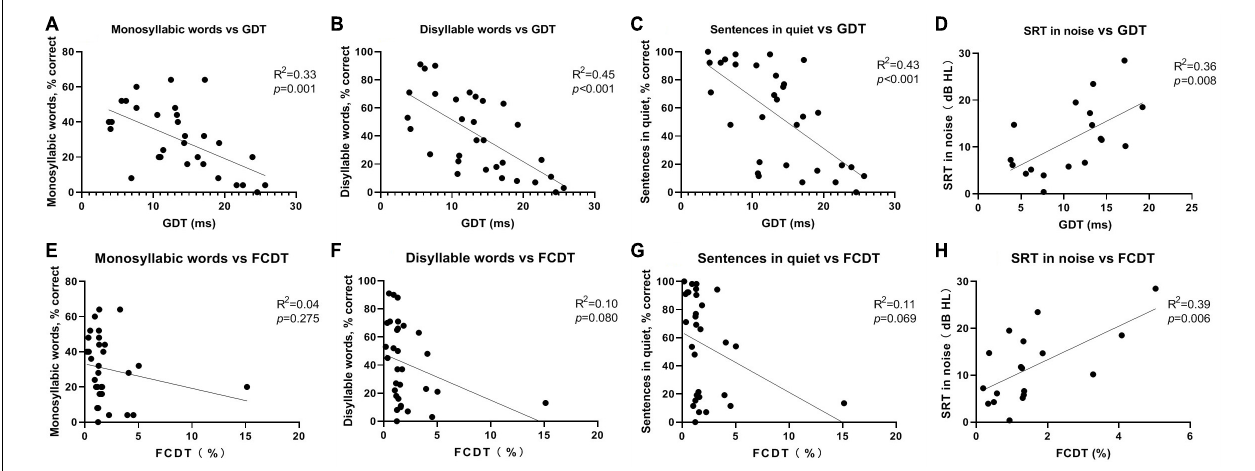
FIGURE 2 | The accuracy rate of monosyllabic words (A) , disyllable words (B) , sentences in quiet (C) as function of GDT for all subjects. The SRT in noise (D) as function of GDT for partial subjects. The accuracy rate of monosyllabic words (E) , disyllable words (F) , sentences in quiet (G) as function of FCDT for all subjects. The SRT in noise (H) as function of FCDT for partial